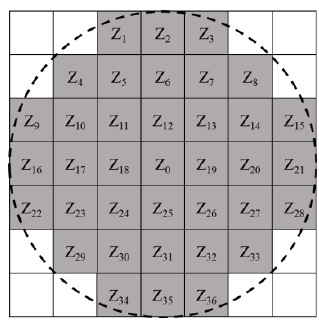
Figure 2. Schematic diagram for grid cells ( Z i ) within a 3 × 3 pixel, circular moving window, where Z 0 is located at the center of the circle.